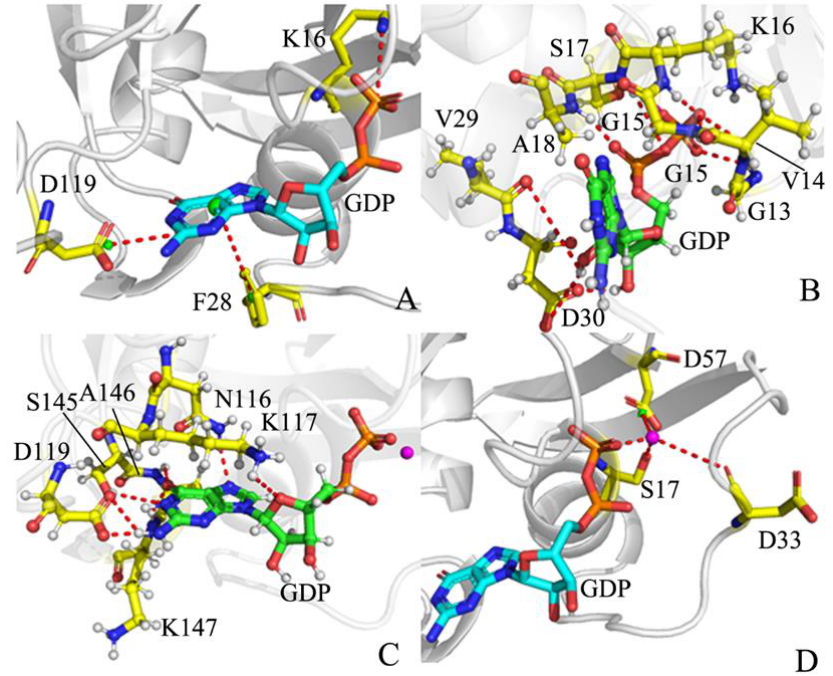
Figure 9. Geometric position of GDP relative to key residues and magnesium ion: ( A ) the salt bridge interactions of GDP with K16 and D119, as well as the π – π interaction of GDP with F28, ( B ) the HBIs of GDP with residues in the P-loop and SW1, ( C ) the HBIs of GDP with residues in the loop L4 and L5, and ( D ) interactions of the magnesium ion with residues and GDP.